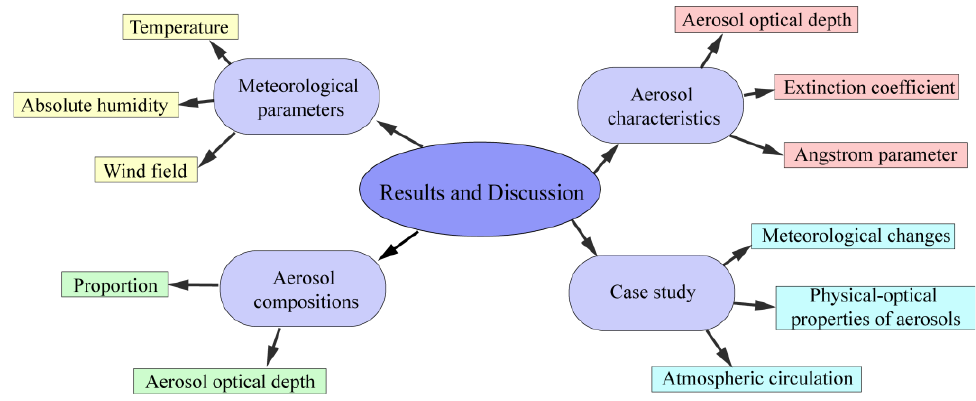
Figure 2. The content framework of Section 3.